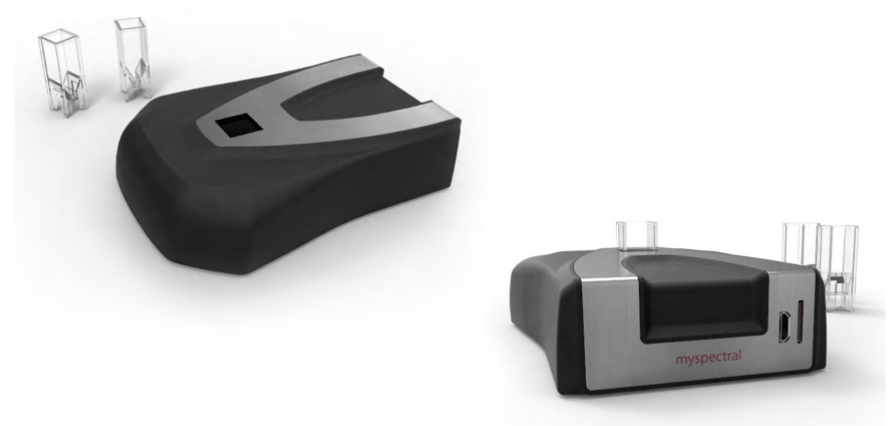
Figure 2. VIS-NIR ultra-compact spectrophotometer Lumini C Myspectral using standard cuvette holder for absorbance spectrophotometry.